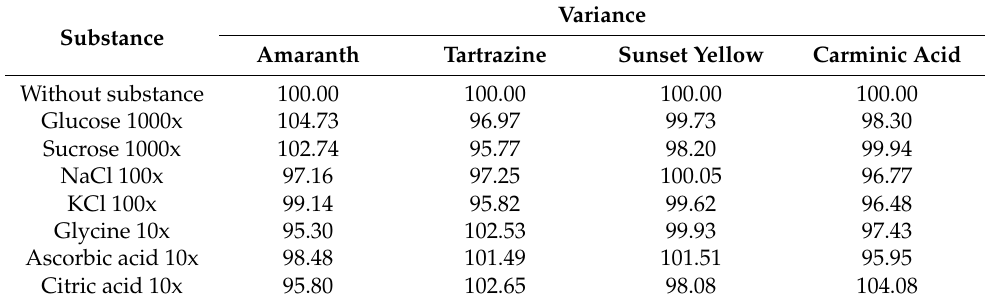
Table 3. Effect of interference substances on rGO-methionine/SPCE with dye concentration at 5 µ M.